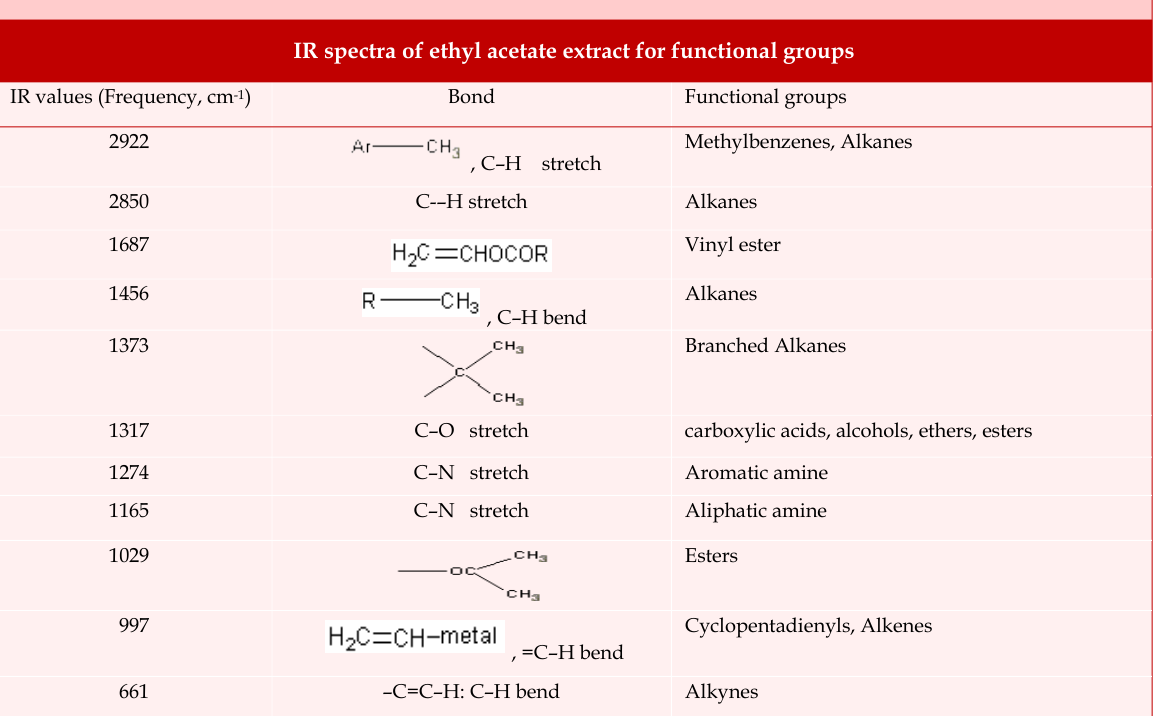
IR spectra of ethyl acetate extract for functional